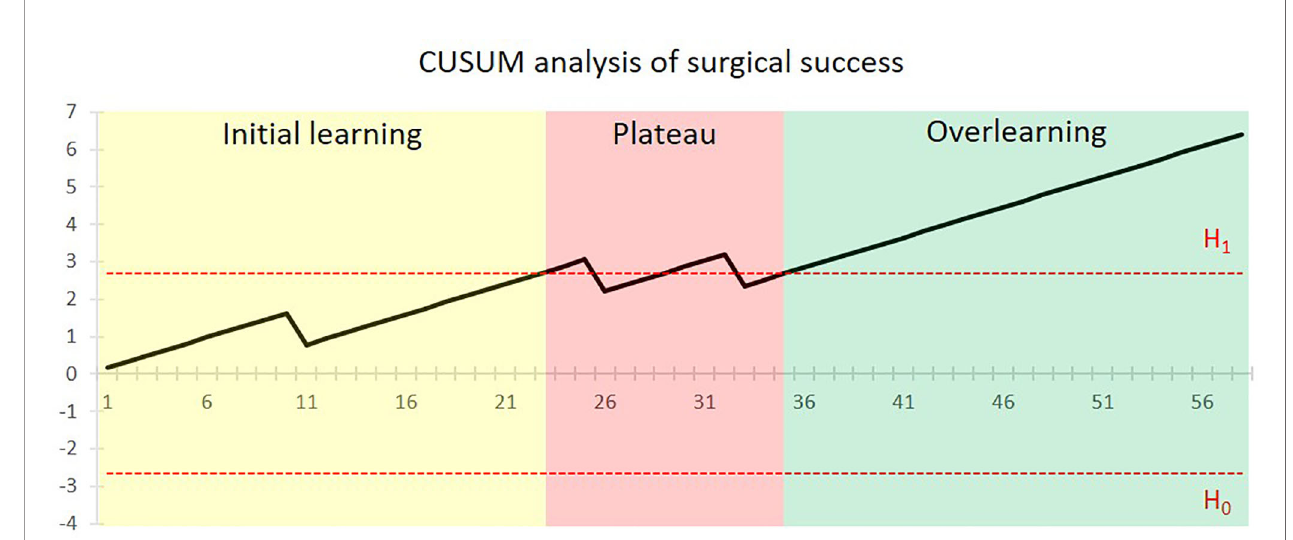
FIGURE 1 | CUSUM analysis of surgical success for the CAJR with PSSP performed by the surgical team. The x -axis shows the chronological sequence of cases. The black line indicates the cumulative sum of surgical success. The horizontal red dotted lines represent the acceptable boundary line H 1 and unacceptable boundary line H 0 . Pro fi ciency was fi rst achieved after 35 cases.